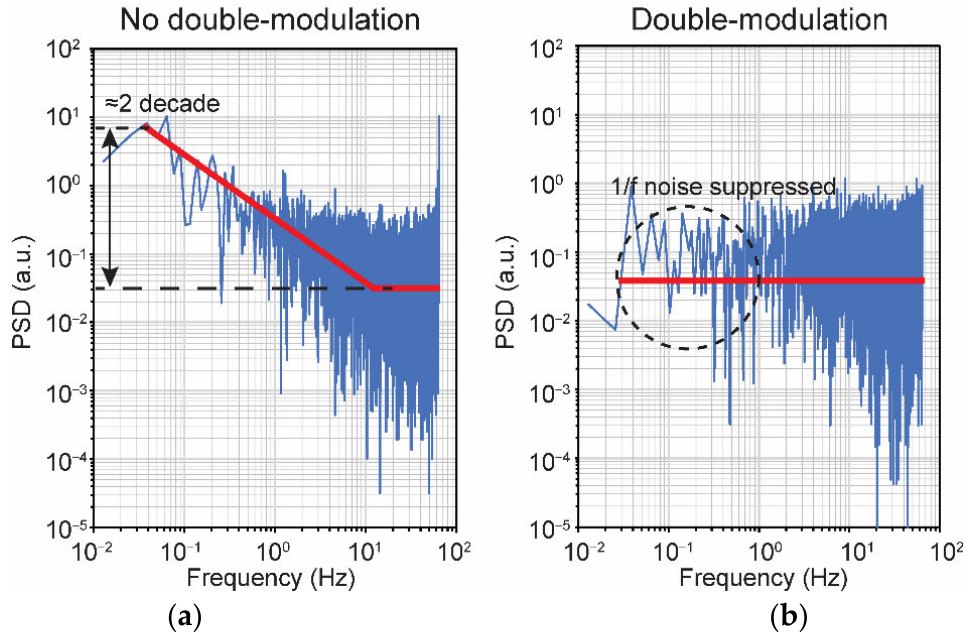
Figure 14. Comparison of noise measurement: ( a ) No double ‐ modulation is applied and ( b ) the dou ‐ ble ‐ modulation is used.